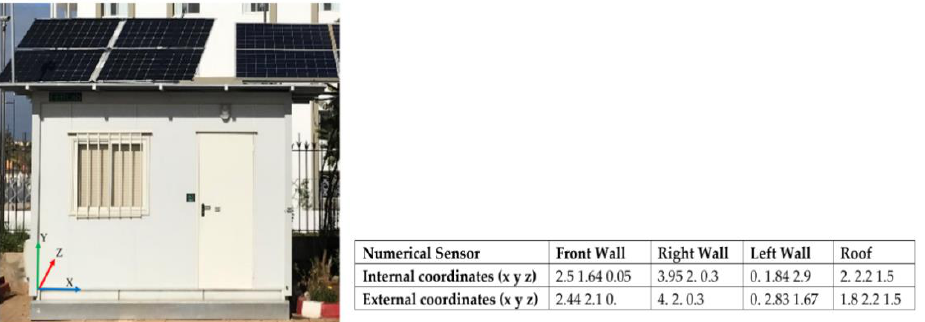
Figure 9. Orthonormal and sensors coordinates.